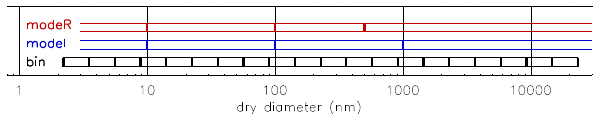
Fig. 2. Schematic diagram showing the mode edge sizes for the original (modeI, blue lines) and revised (modeR, red lines) con- figurations of GLOMAP-mode. The template size bin interfaces in the moving-centre, fixed-edge GLOMAP-bin sectional approach are also soon (bin, black